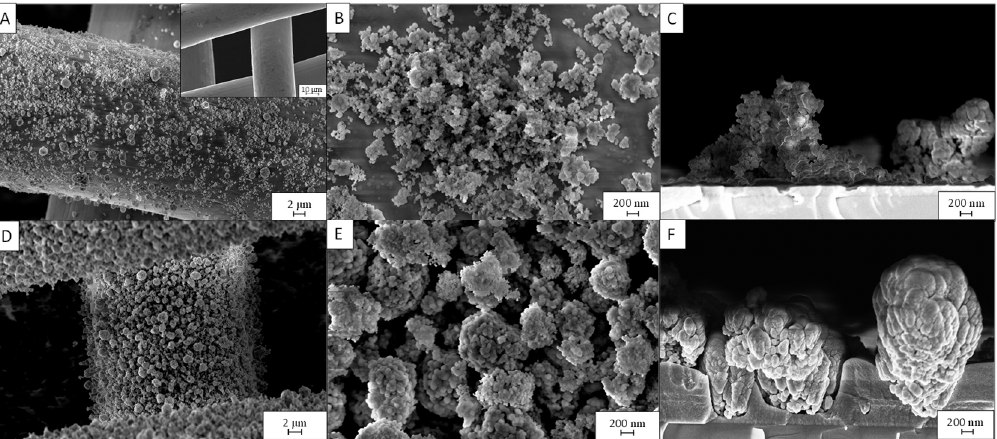
Figure 1. SEM micrographs of the PD3m sample at different magnifications: ( A ) top view 5kx and, in the inset, the bare woven stainless-steel mesh; ( B ) top view 50kx; ( C ) cross section 50kx. The PD20m sample at different magnifications: ( D ) top view 5kx, ( E ) top view 50kx, ( F ) cross section 50kx. Cross section from samples deposited onto c-silicon.